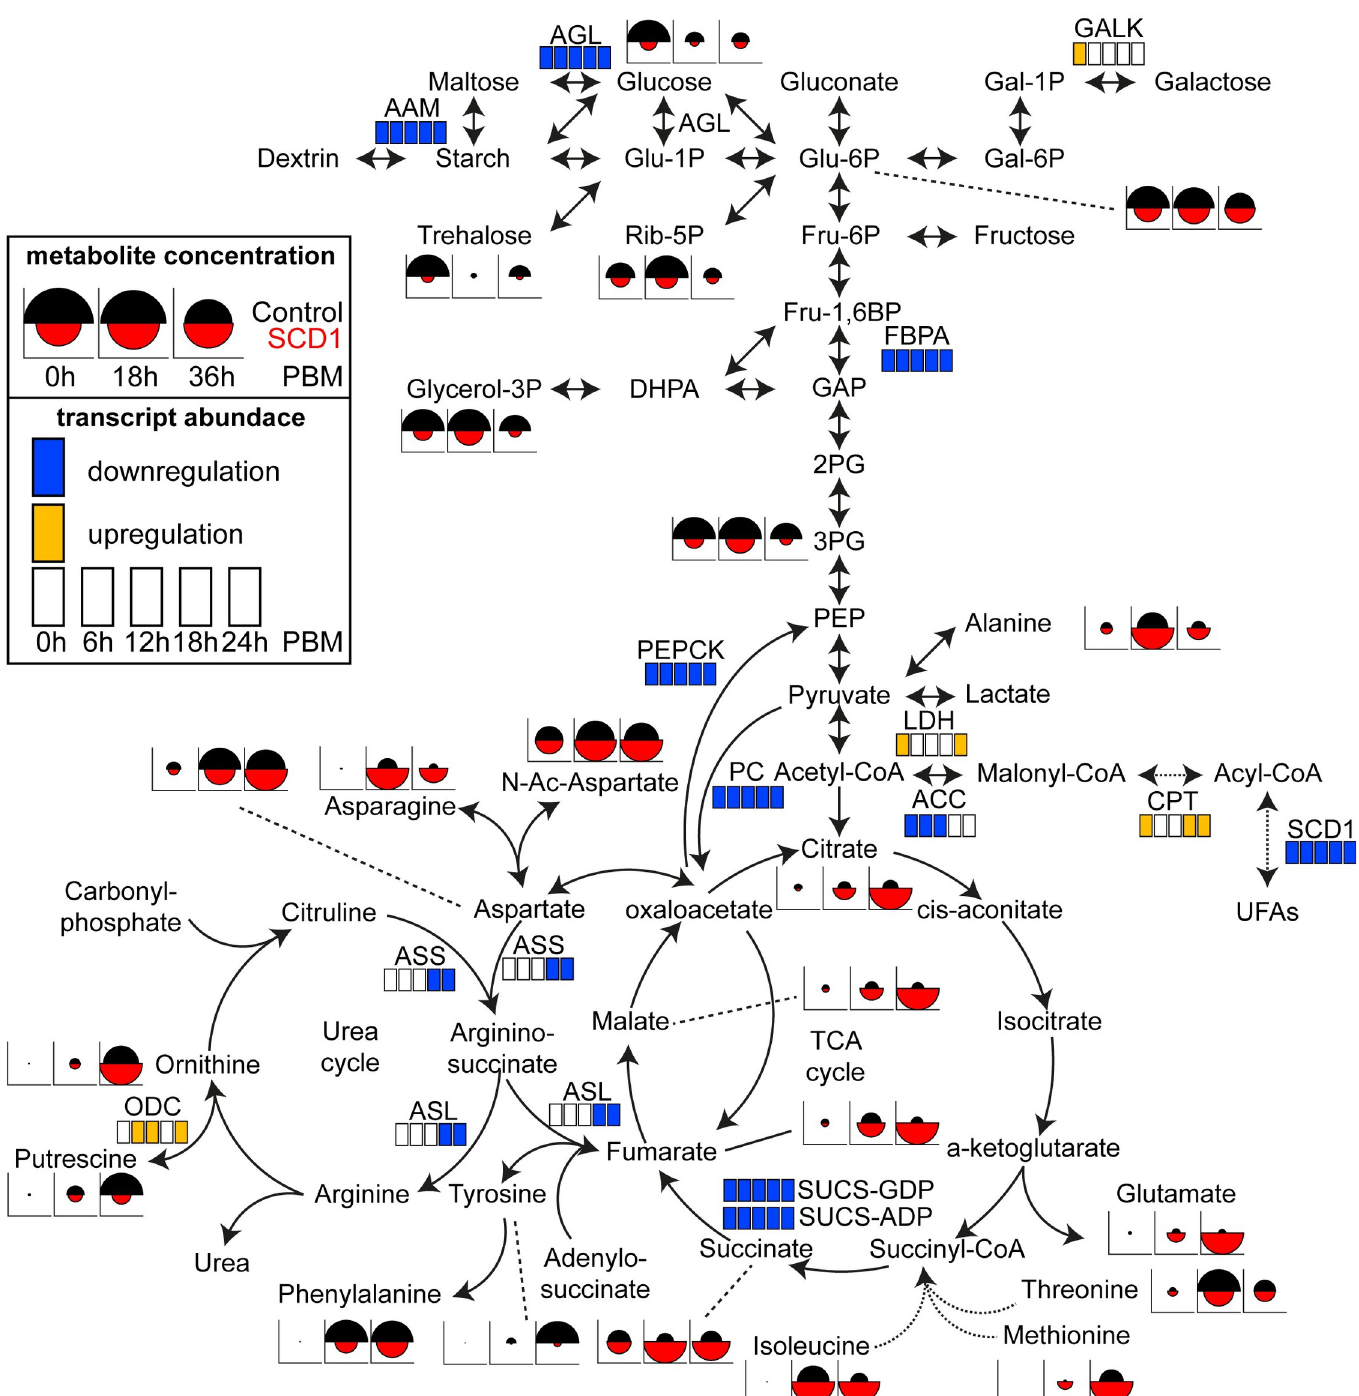
Fig 5. Integrative analysis of metabolic pathways. Metabolite and transcript abundance differences between ds SCD1 (KD) and ds LaZ (control) injected mosquitoes are mapped on reconstructed KEGG pathways encompassing glycolysis, gluconeogenesis, TCA cycle and Urea cycle. Transcript differences in any of five time points are indicated as upregulated (yellow) or downregulated (blue) when 2-fold or more expression changes are documented in SCD1 KD versus control mosquitoes (p < 0.05 in ANOVA t-test). The metabolite data were normalized for each metabolite basis and plotted as circle fragments of which the radius is directly proportional to the highest value for the metabolite in any of the three time points and two conditions. AGL, α -glucosidase; AAM, α -amylase; PC, pyruvate carboxylase; PEPCK, phosphoenol pyruvate carboxykinase; LDH, lactate dehydrogenase; GALK, galactokinase; LDH, lactate dehydrogenase; FBPA, fructose-bisphosphate aldolase; SUCL-GDP, succinate- CoA ligase; SUCS-ADP, succinate-CoA synthetase; ACC, acetyl-CoA carboxylases; ASS, arginosuccinate synthase; ASL, arginosuccinate lyase; ODC, ornithine